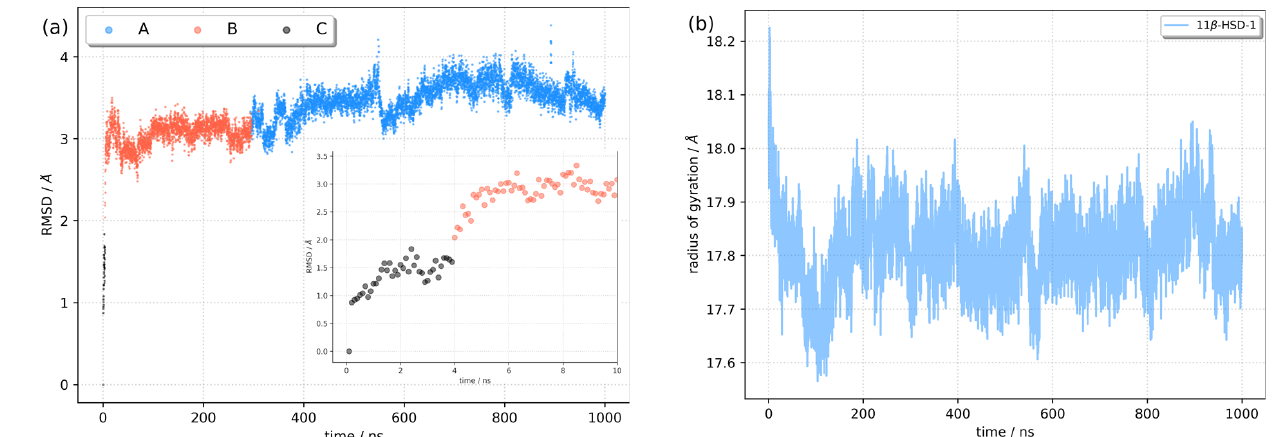
Figure 4. Stability of the RES:11 β -HSD-1 complex during molecular dynamics simulation. ( a ) Root mean square deviation with position of the representative conformations shown (A, B, C, vide infra) and ( b ) radius of gyration.